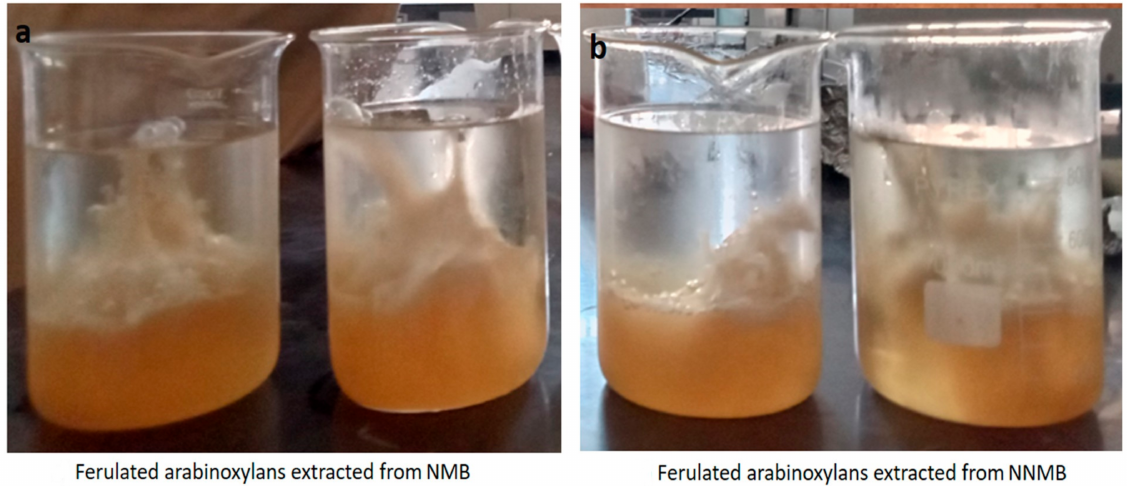
Figure 1. Extraction of FAXs from ( a ) NMB and ( b )